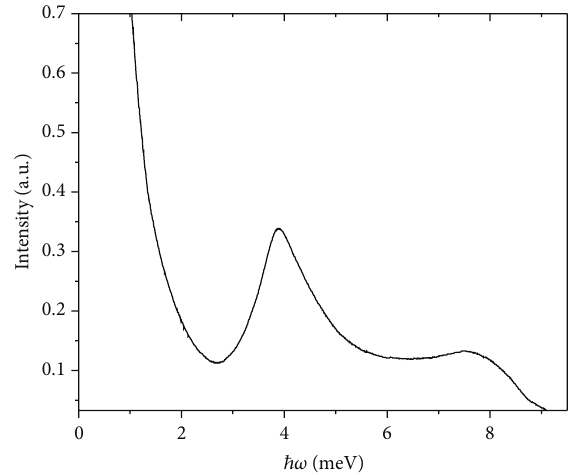
Figure 1: The double-peak structure of the spectrum of density fluctuations of water as derived in the computational work of Rahman and Stillinger [15] and at 𝑄 = 3.34 nm −1